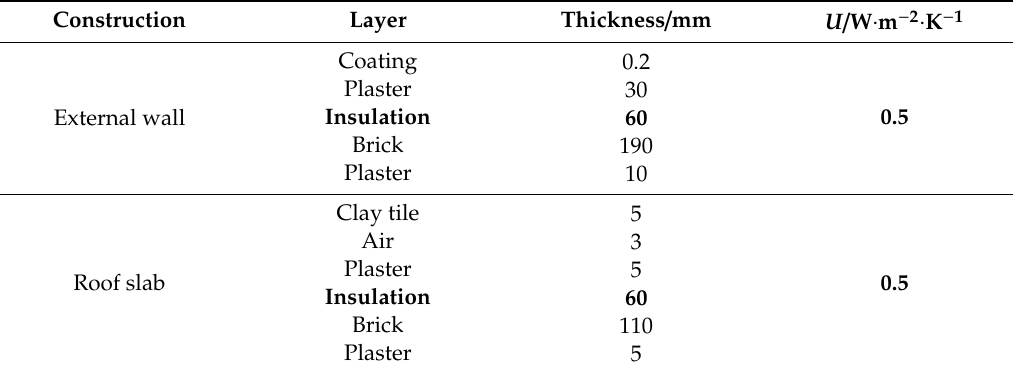
Table 2. Construction details of case BD2—di ff erences from BD1 in